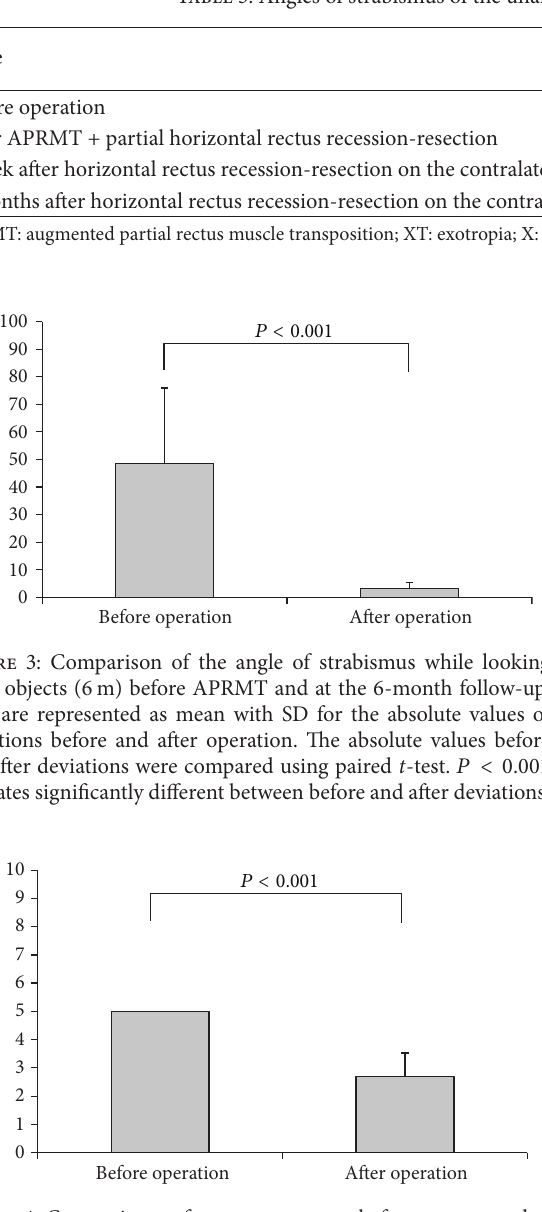
Figure 4: Comparisons of movement scores before surgery and at the 6-month follow-up. Data were represented as mean with SD error bar for in the absolute movement scores before and after operation, respectively. The absolute pre- and postmovement scores were compared using paired t -test. 𝑃 < 0.001 indicates significantly different between pre- and postmovement scores.